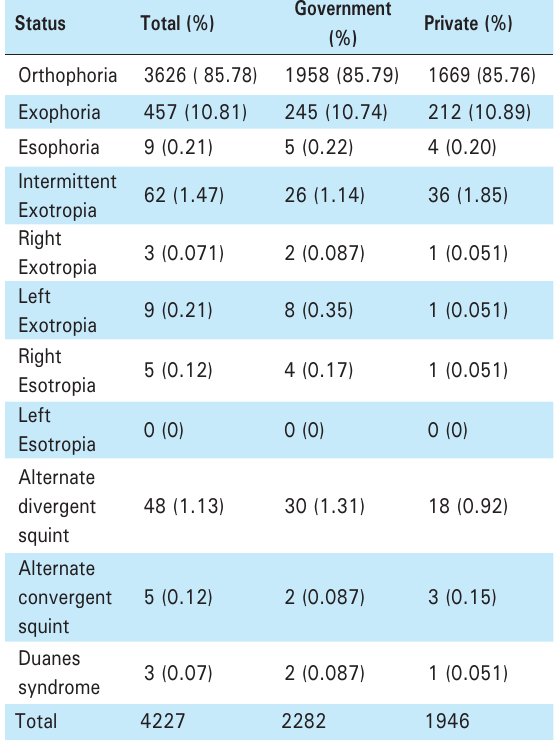
Table 3. Binocular vision status of the